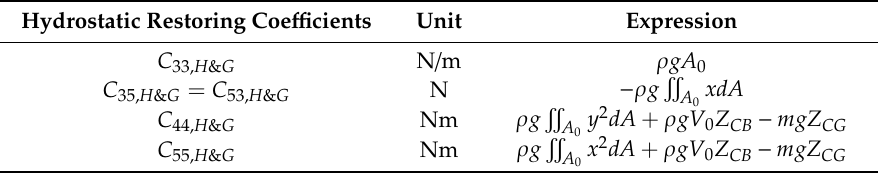
Table 2. Hydrostatic and gravitational restoring coe ffi cients.